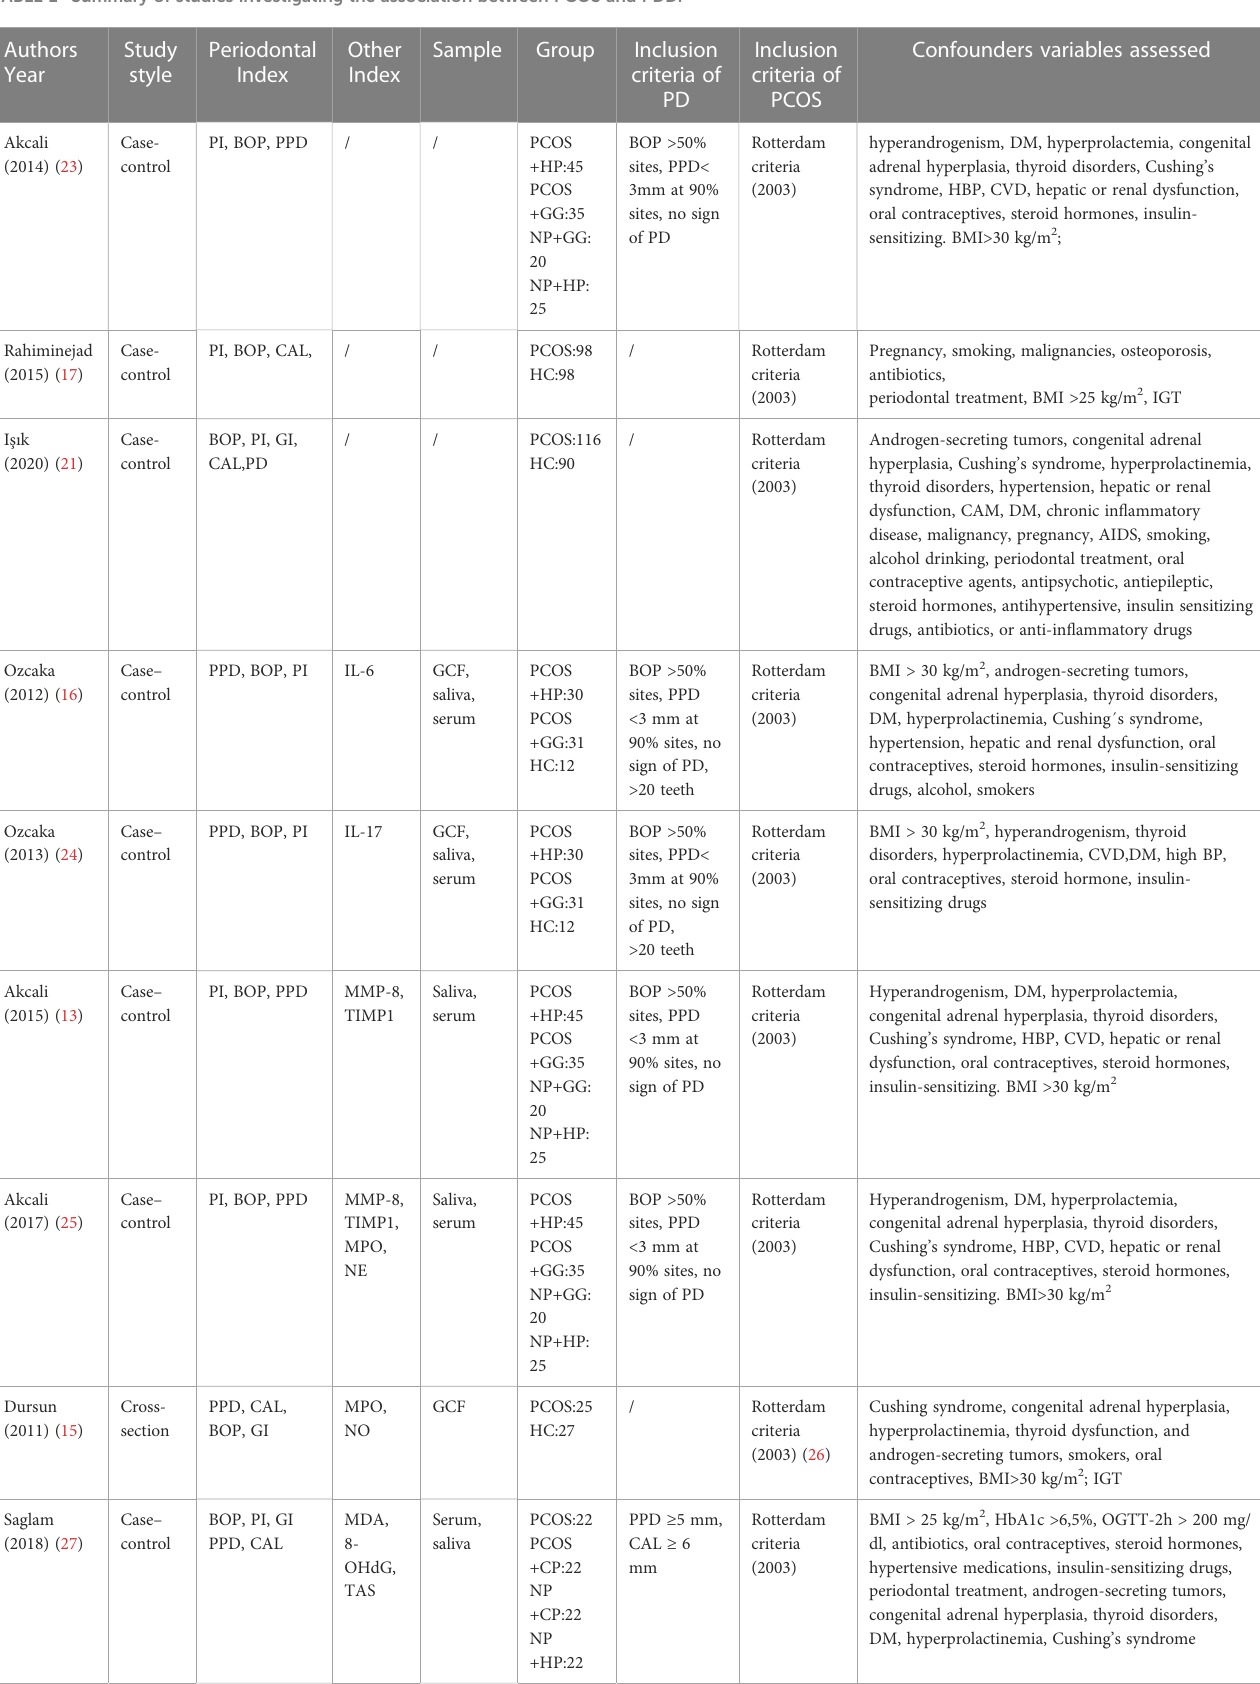
TABLE 1 Summary of studies investigating the association between PCOS and